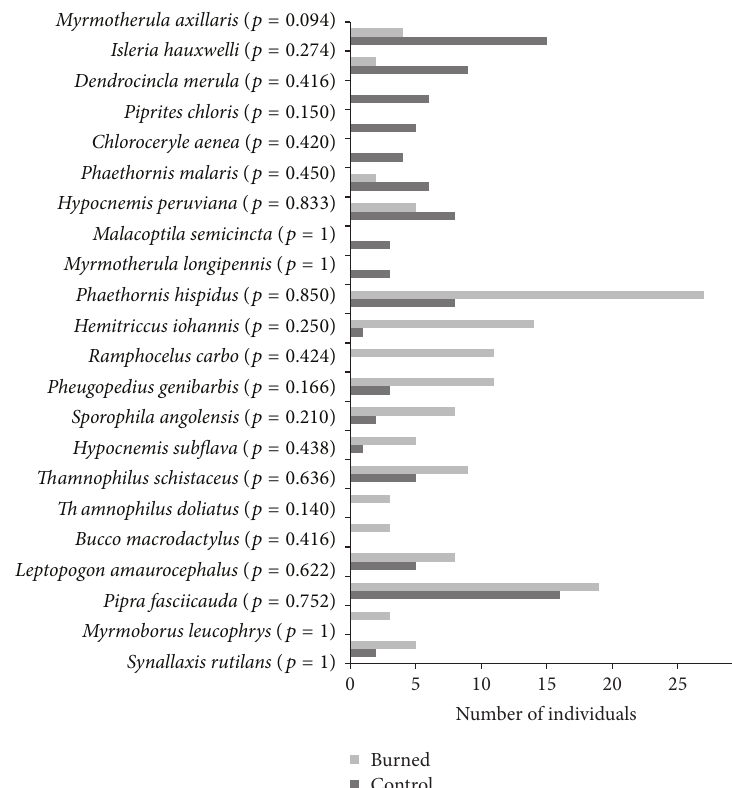
Figure 4: Relative abundance of the most common bird species captured in the burned and control plots in the present study in eastern Acre, Brazil. The probability ( p ) values presented for each species refer to the results of the two-sample permutation tests for the comparison of the samples from control and burned